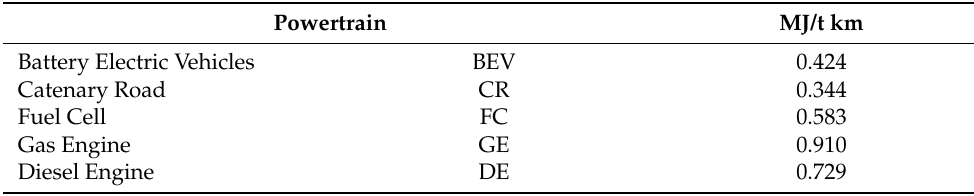
Table 1. Efficiencies of various